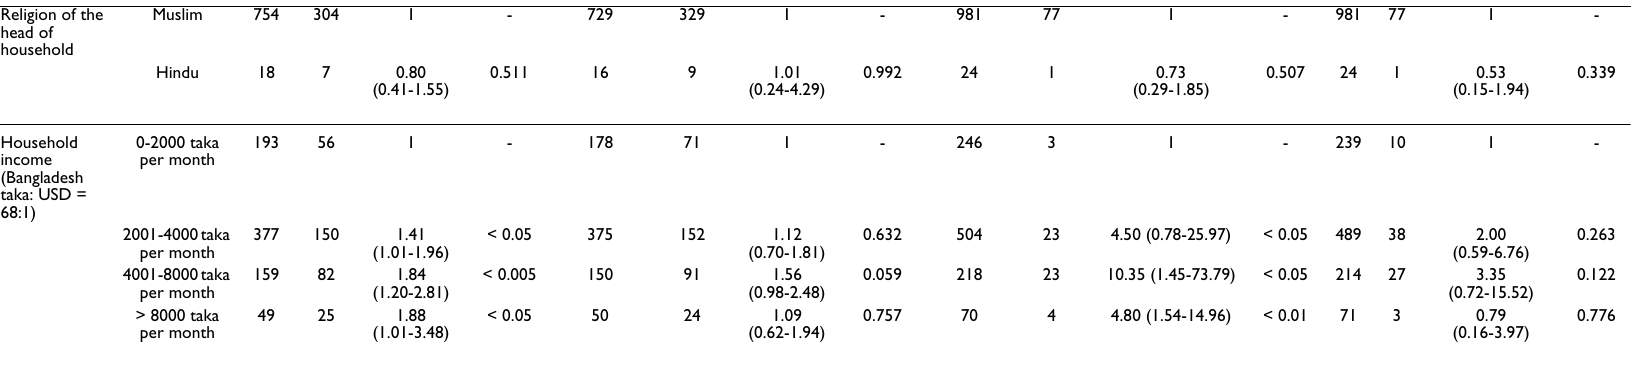
Table 4: Exposure variables of organised crime and political violence (OPV) and human rights violations